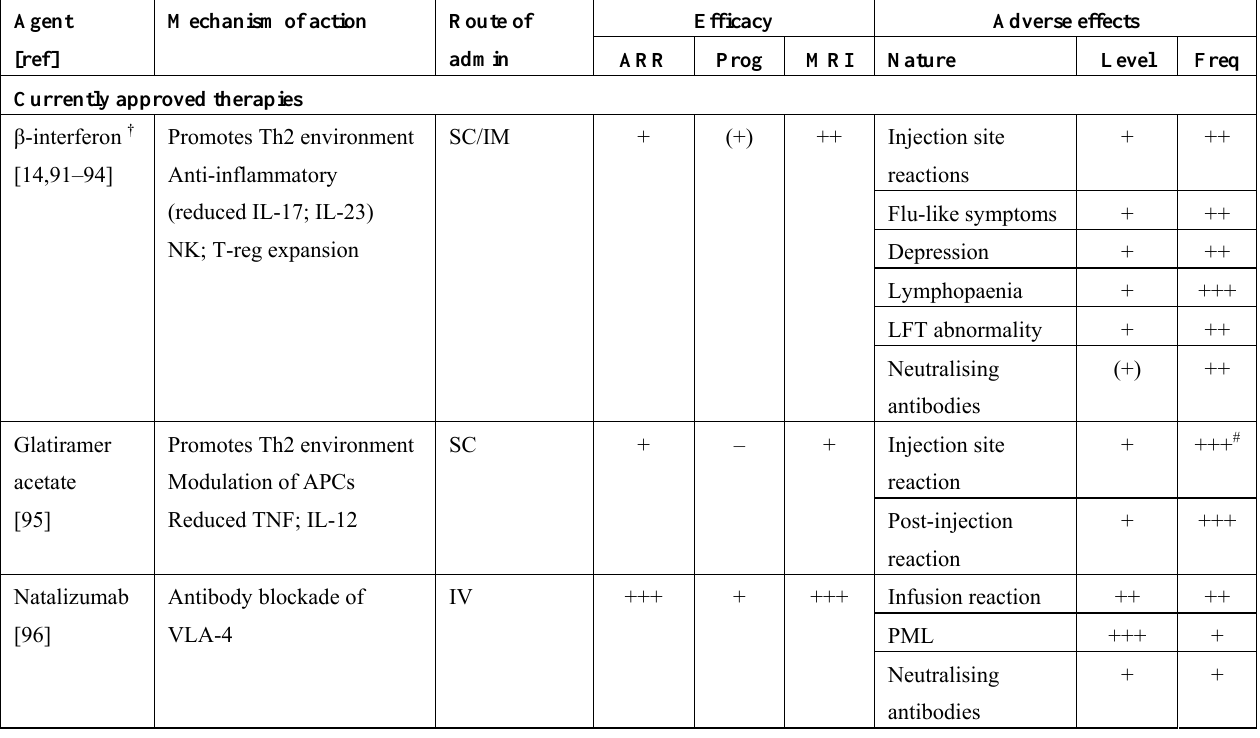
Table 1. Summary of MS treatments with phase III